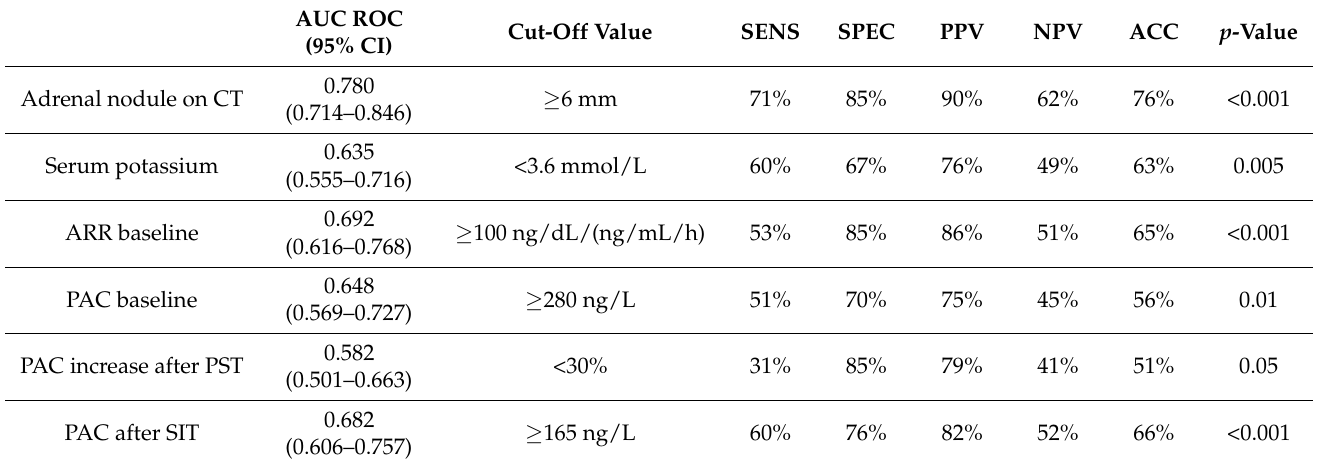
Table 2. Diagnostic values of the screening tests for unilateral PA in the development cohort.